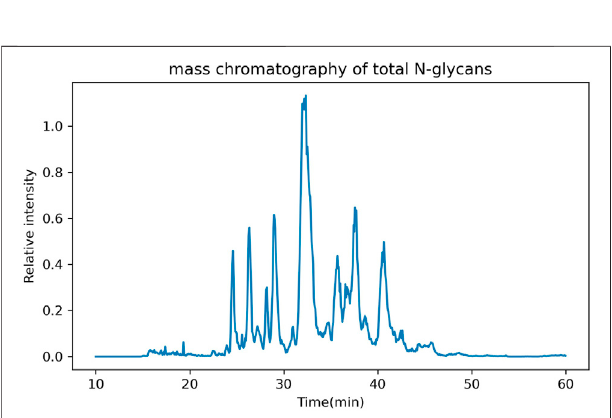
FIGURE 7 | The full mass chromatography of the total N-glycans from human serum spiked dextrin.